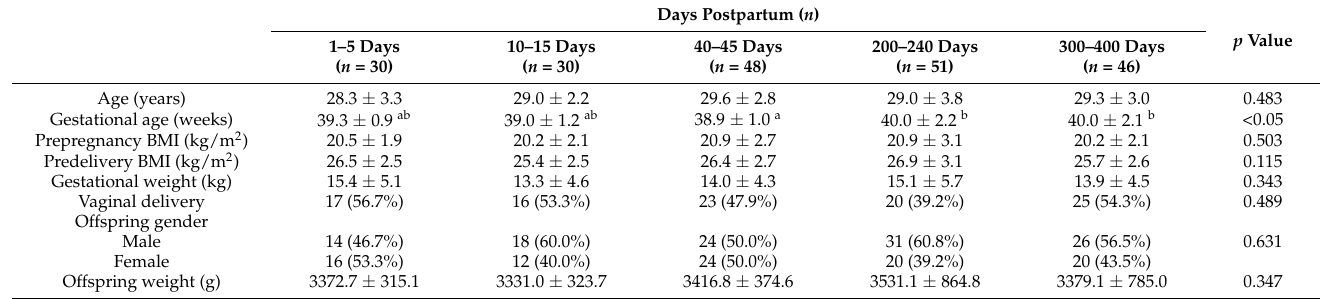
Table 1. Characteristics of participant mothers and corresponding infants at each sampling